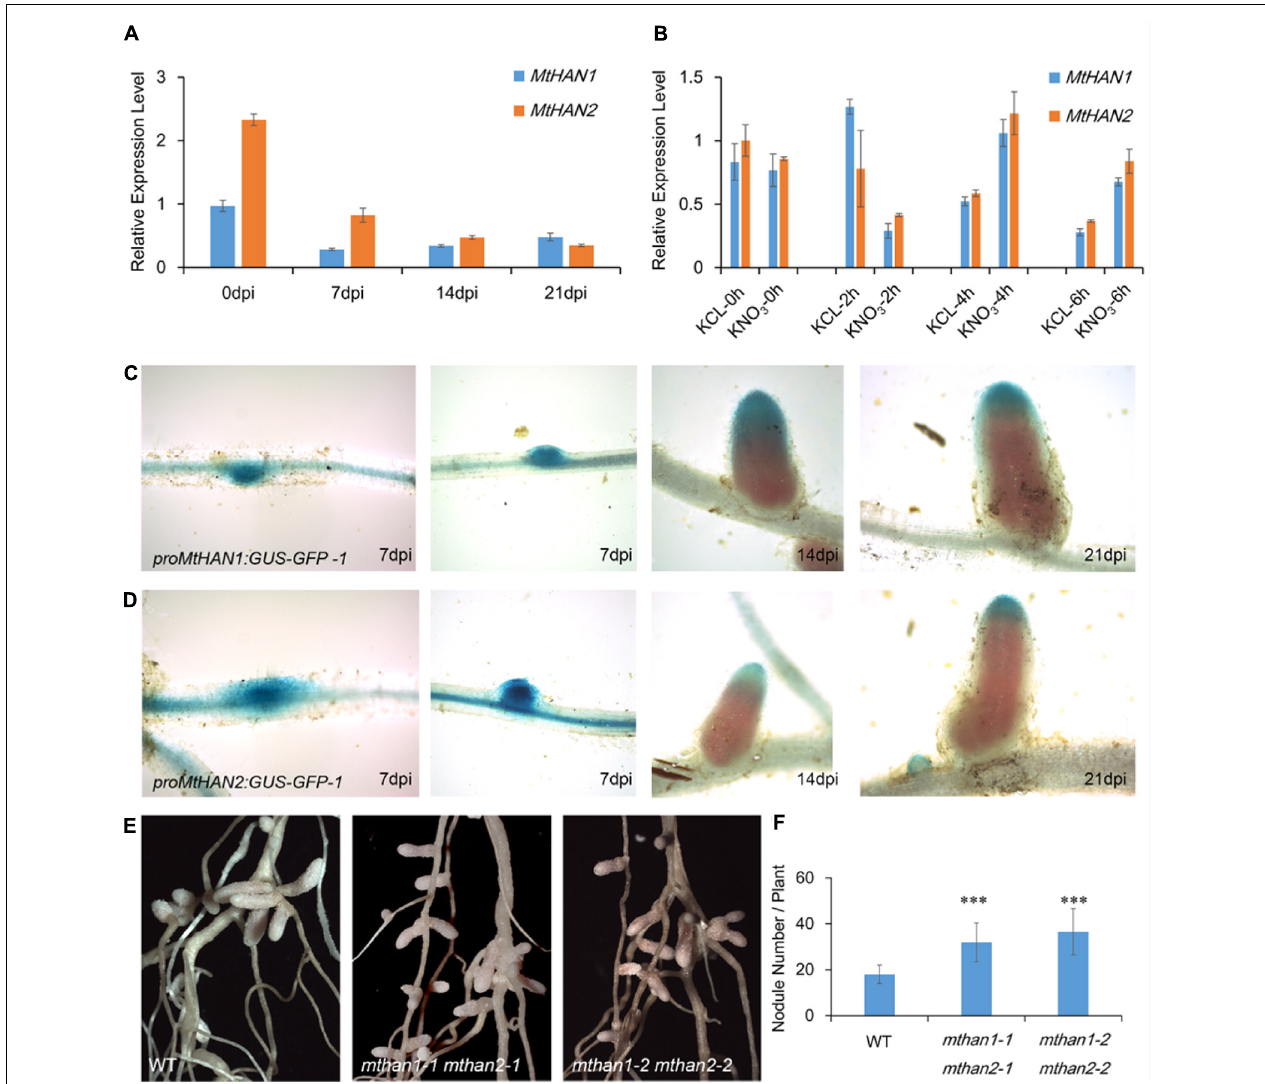
FIGURE 5 | MtHAN1 and MtHAN2 express in nodules and the mthan1 mthan2 double mutant has an increased nodule number. (A) Expression pattern of MtHANs in different developmental stages of nodule. The root (0 dpi) was used as control. Values are the means ± SD of three biological replicates. (B) Expression pattern of MtHANs in leaves and petioles after nitrate treatment, KCl treatment as control. Values are the means ± SD of three biological replicates. (C,D) ProMtHAN1: GUS–GFP and proMtHAN2:GUS–GFP reporter activity associated with the progressive stages in nodule development. (E) Photos of nodules from WT and mthan1 mthan2 at 21 dpi. (F) The average number of nodules in WT and mthan1 mthan2 plants. Values are the means ± SD ( n = 16). ∗∗∗ P <